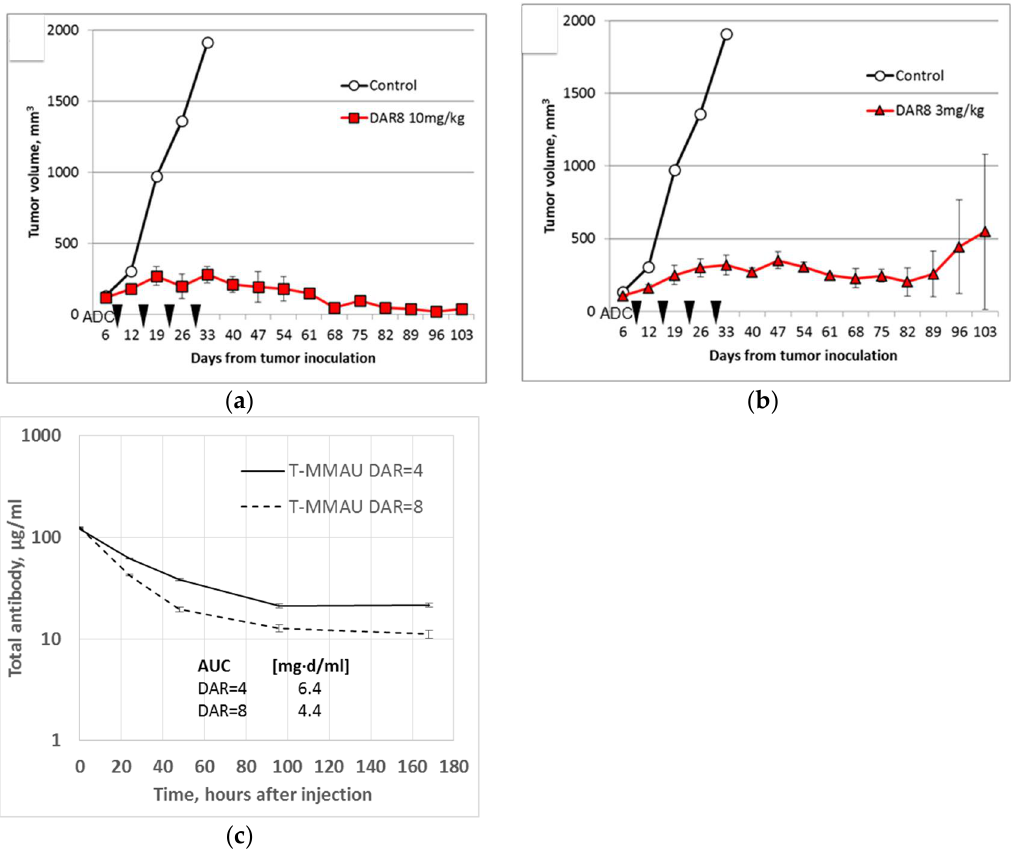
Figure 4. In vivo experiments. ( a , b ) EGFR + HSC-2 tumor xenografts in mice were effectively treated with anti-EGFR DAR = 8 MMAU ADCs based on cetuximab. Mice were inoculated with tumor cells and treatment was given intravenously either with ( a ) 10 mg/kg or ( b ) 3 mg/kg ADC once weekly for four weeks (arrows). With the larger dose ( a ) the tumors shrunk permanently (follow-up of 100 days) and with the lower dose ( b ) the growth of the tumors was arrested in all but one mice (recurrence after 80 days). There were three mice in each treatment group. Error bars show the standard error of the mean. ( c ) Trastuzumab-MMAU ADCs (T-MMAU) were given to nude mice as single 10 mg/kg i.v. injection. DAR = 8 MMAU ADC showed 31% smaller area under curve (AUC) than DAR = 4 MMAU ADC. There were three mice in each treatment group. Error bars show the standard deviation.